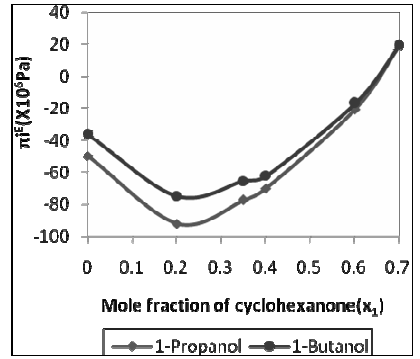
Figure 3. Variation of excess molar volume versus mole fraction of cyclohexanone (X